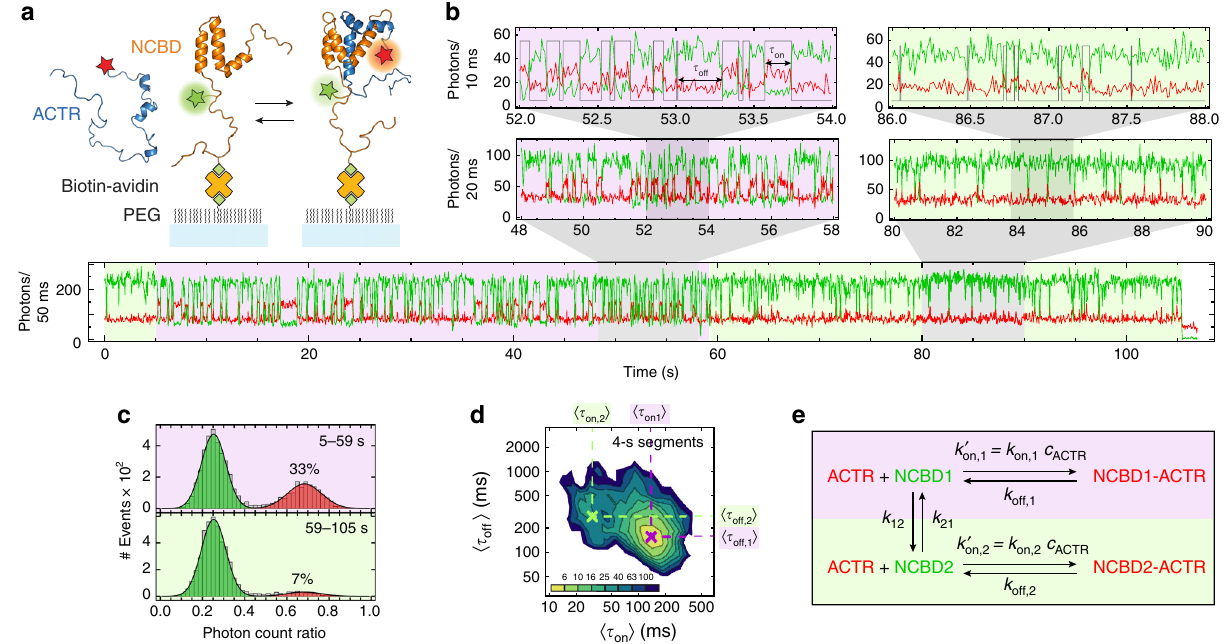
Fig. 1 Binding of ACTR to single surface-immobilized NCBD molecules. a Schematic representation of acceptor-labeled ACTR (blue) binding to surface- immobilized donor-labeled NCBD (orange). b A single-molecule time trace showing donor (green) and acceptor fl uorescence (red) until donor photobleaching, with progressive magni fi cations above. A period where ACTR forms relatively long-lived complexes with NCBD is shaded in purple; binding events are sparser and on average shorter in the segments shaded in light green. The most likely state trajectory (bound/unbound) identi fi ed by the Viterbi algorithm is depicted as gray lines for the largest magni fi cation. 283 binding events were identi fi ed in this time trace. Note that the lower quantum yield of the acceptor compared to the donor dye leads to a decrease in total fl uorescence intensity upon ACTR binding. c Histograms of photon count ratios (acceptor over total number of photons) for the two kinetic regimes in b , calculated for 20-ms time bins. The two populations arise from the unbound (green, low photon count ratio) and the bound state (red, high photon count ratio) of NCBD; the corresponding fractions bound and the time ranges in the trajectory are indicated. d 2D histogram of the mean time in the bound state, 〈 τ on 〉 , and in the unbound state, 〈 τ off 〉 , generated by splitting all 163 measured time traces into 4-s segments, resulting in two clusters. e Kinetic binding model used to analyze the time traces, including the interconversion between the two states of NCBD with different kinetics of dissociation and association with